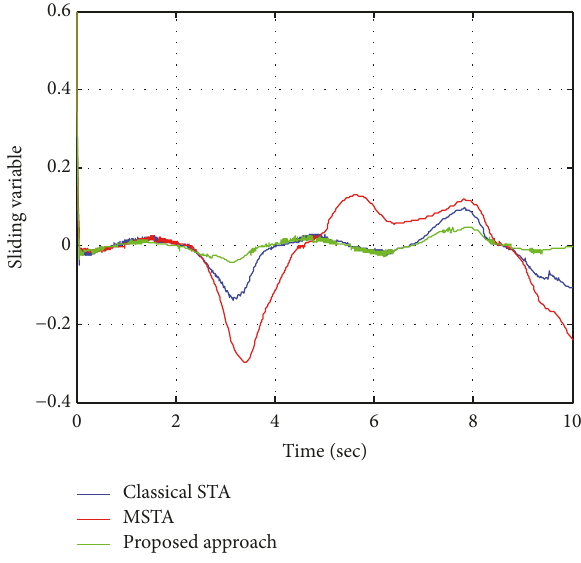
Figure 5: Sliding variable 𝜎(𝑡)